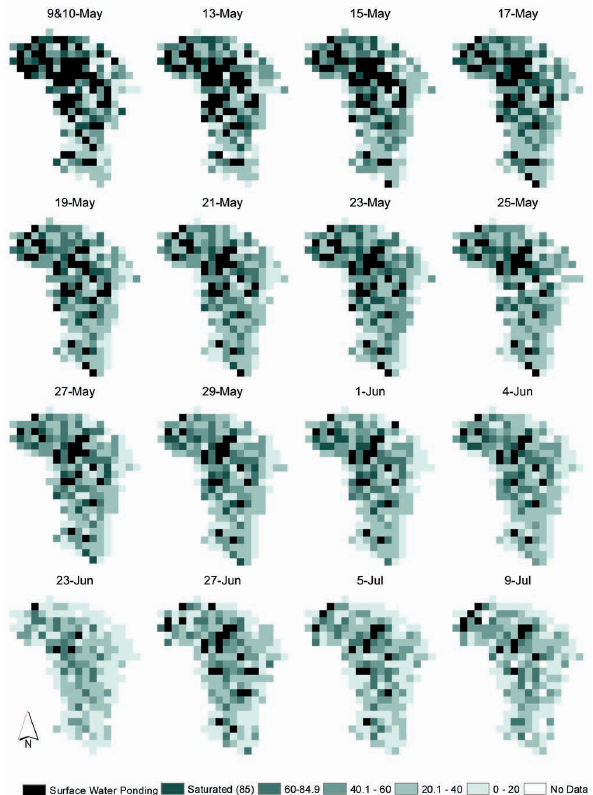
Fig. 3. Shallow soil moisture surveys at the peatland site. All values are in % and grid cells are mapped at a resolution of 8m by 8m from 8m by 4m survey